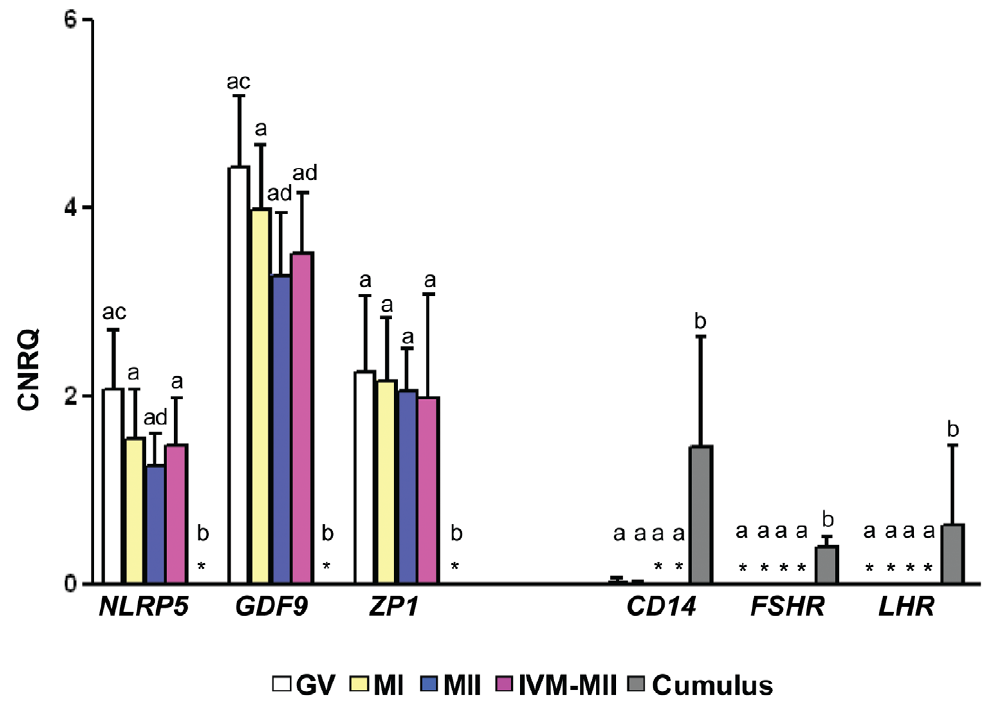
Figure 1. Expressions of oocyte-specific or cumulus cell-specific genes. Values are the means of different stages of oocytes including GV (N=10), MI (N=8), MII (N=9), IVM-MII (N=10) and cumulus cells (N=5). Error bars represent standard deviation (SD). CNRQ: calculated normalized relative quantity. *: Not detected in all samples. a,b or c,d : Values were significantly different (P , 0.05).